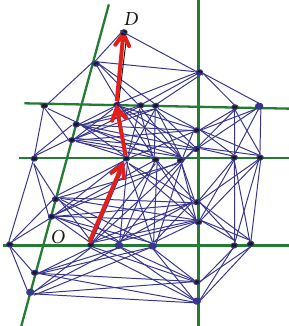
Figure 2: An example of vehicle guidance in the higher level network.